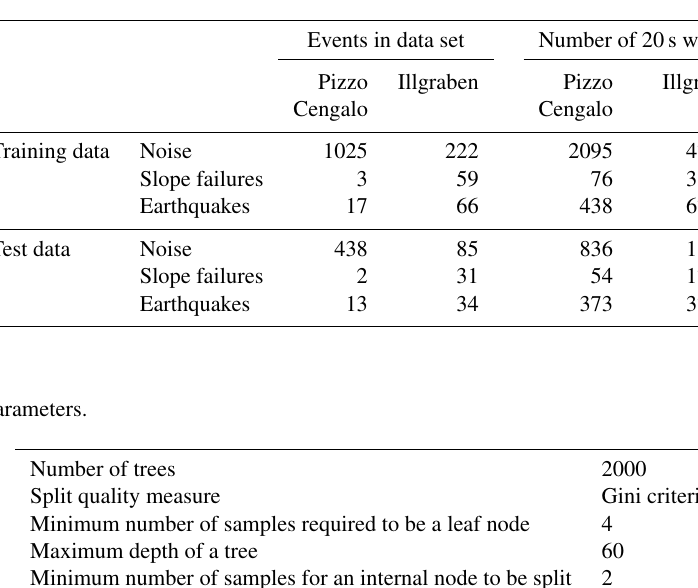
Table B2. Number of events and number of windowed seismic data (20s windows as an example) of the training and test data set of Pizzo Cengalo and Illgraben.